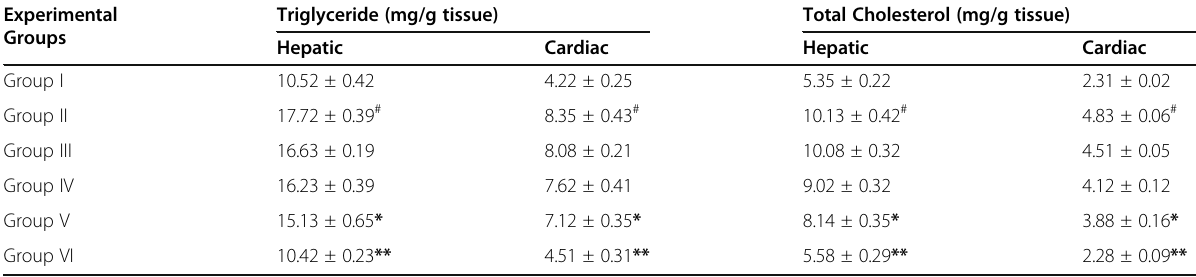
Table 4 Hepatic and Cardiac Triglyceride and Cholesterol Levels in Experimental Rats Experimental Groups